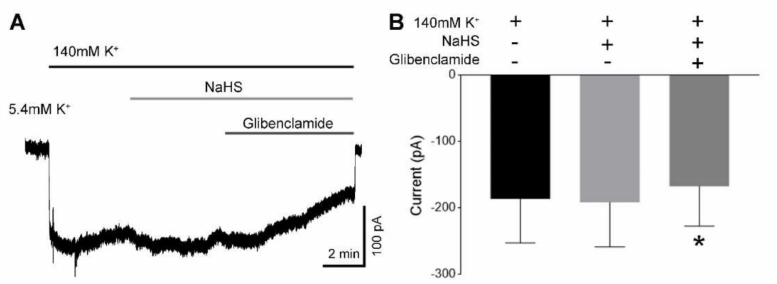
Figure 7. H 2 S on K ATP channel activity in hUASMC. ( A ) K ATP channel currents were recorded with symmetrical 140 mM K + with 0.3 mM ATP in the pipette solution and the membrane potential was held at − 60 mV. NaHS (300 µ M) did not a ff ect the inward K + currents. ( B ) Co-incubation with the K ATP channel blocker glibenclamide (10 µ M) inhibited the inward currents significantly, as shown in ( B ). * p < 0.05 vs. baseline current induced by 140 mM K + without NaHS and glibenclamide. n = 3 /